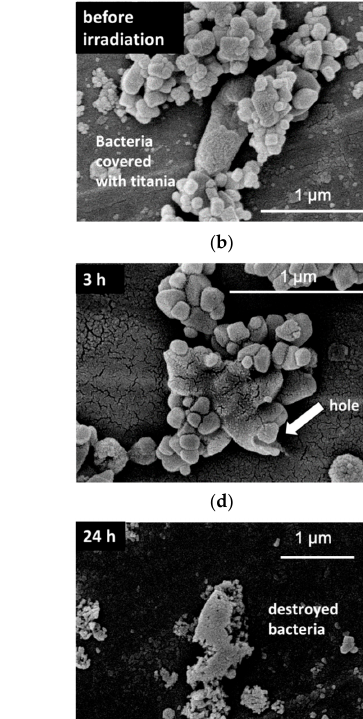
Figure 4. E. coli decomposition presented as a decrease in bacteria number (closed symbols) and CO 2 evolution (open symbols), tested in the suspension of titania under vis irradiation ( λ > 450 nm) and in the dark; adapted with permission (after formatting) from [114]. Copyright 2015 Elsevier.